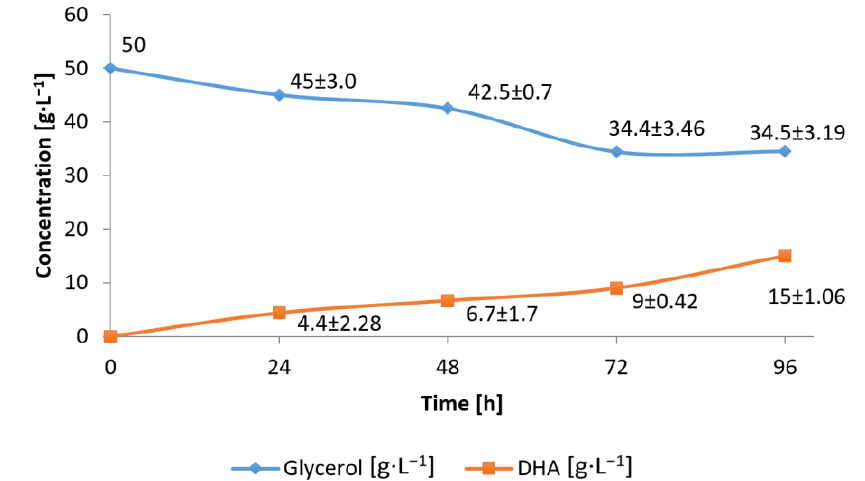
Figure 8. Time profiles of glycerol conversion and DHA formation during bioconversion of 50 g · L − 1 of a waste glycerol fraction with free cell extract obtained from G. oxydans .